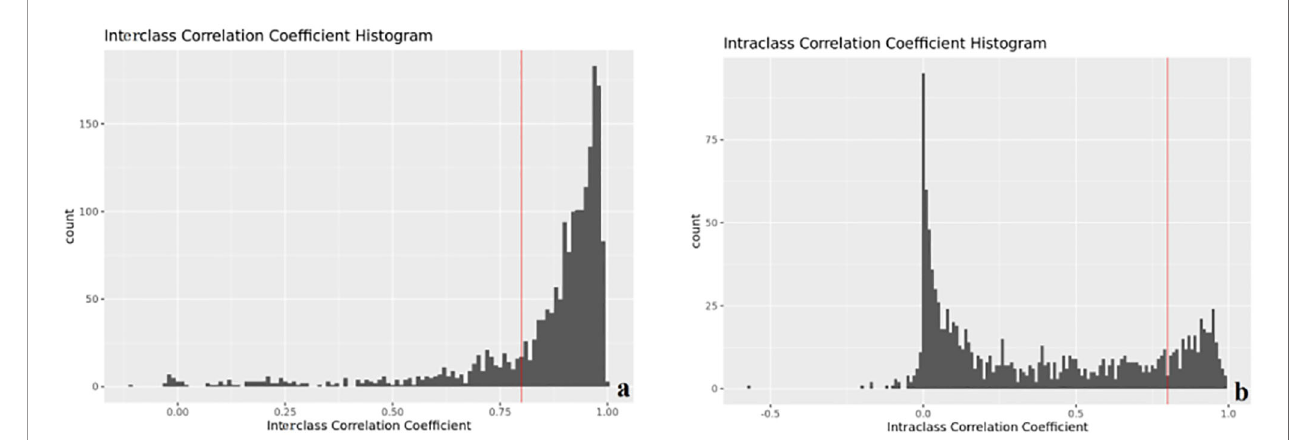
FIGURE 3 | Interobserver (A) and intraobserver (B) consistency